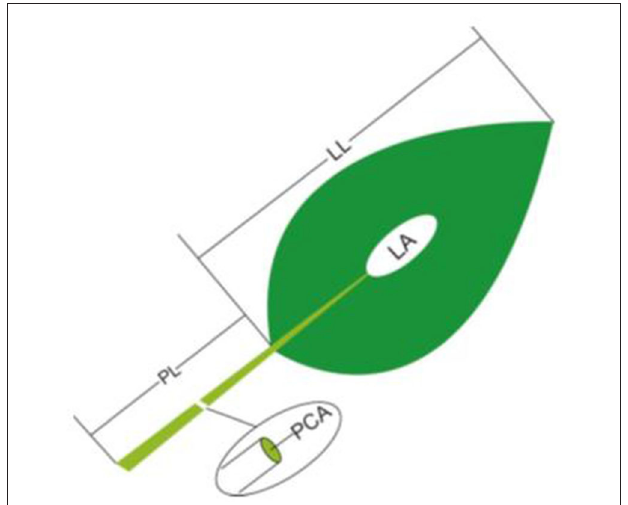
FIGURE 1 | Schematic representation of the method of leaf trait measurement. PL, petiole length; LL, lamina length; PCA, petiole crosssectional area; LA, lamina